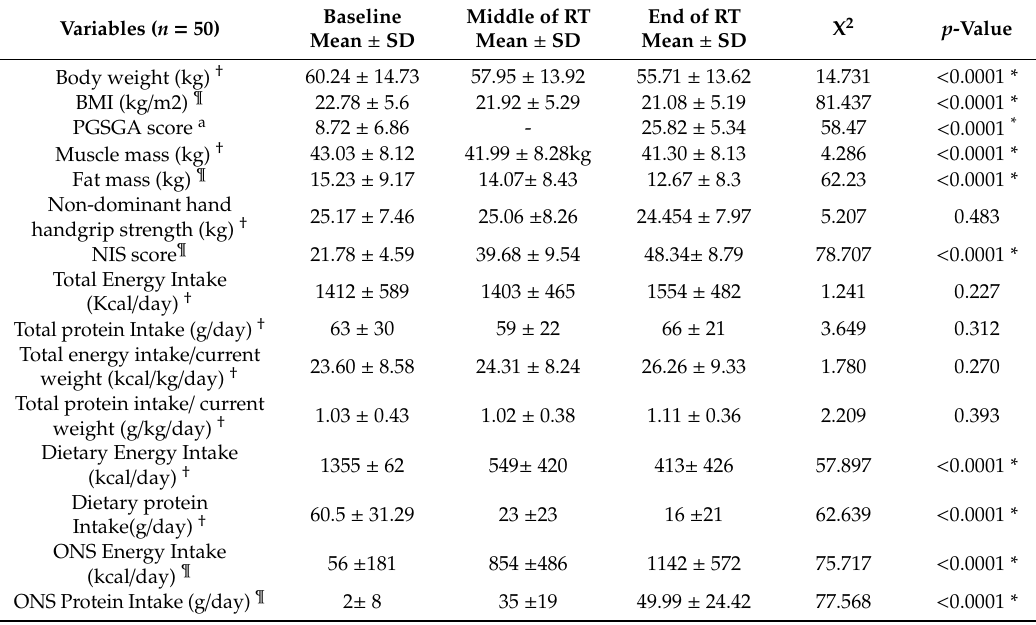
Table 3. Changes in nutritional parameters along the treatment ( n =